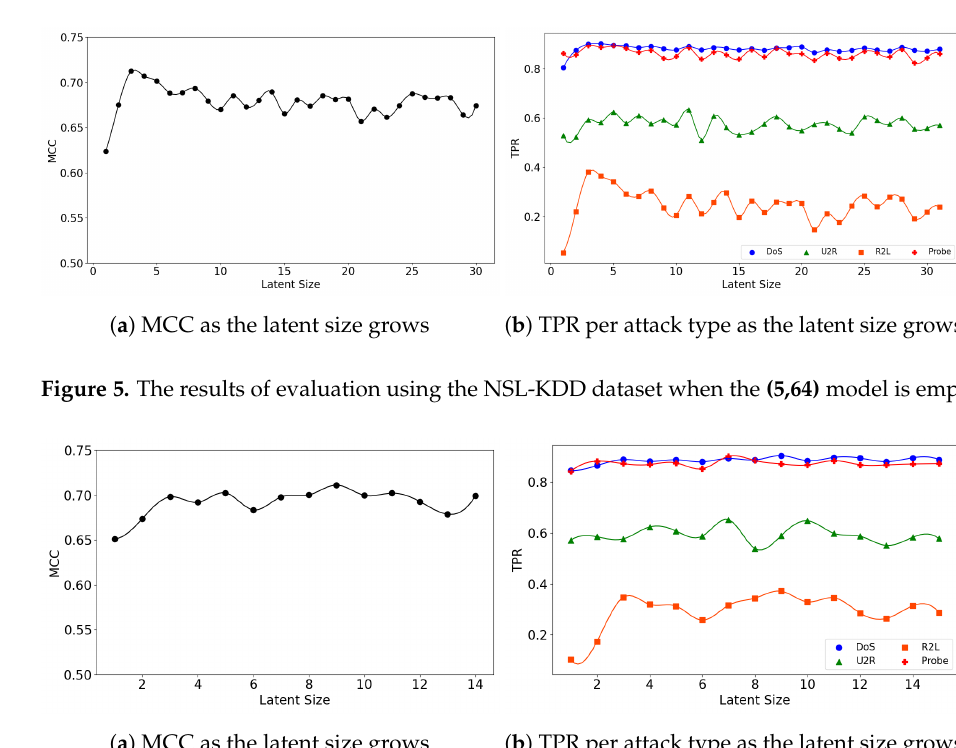
Figure 4. The results of evaluation using the NSL-KDD dataset when the (5,32) model is employed.